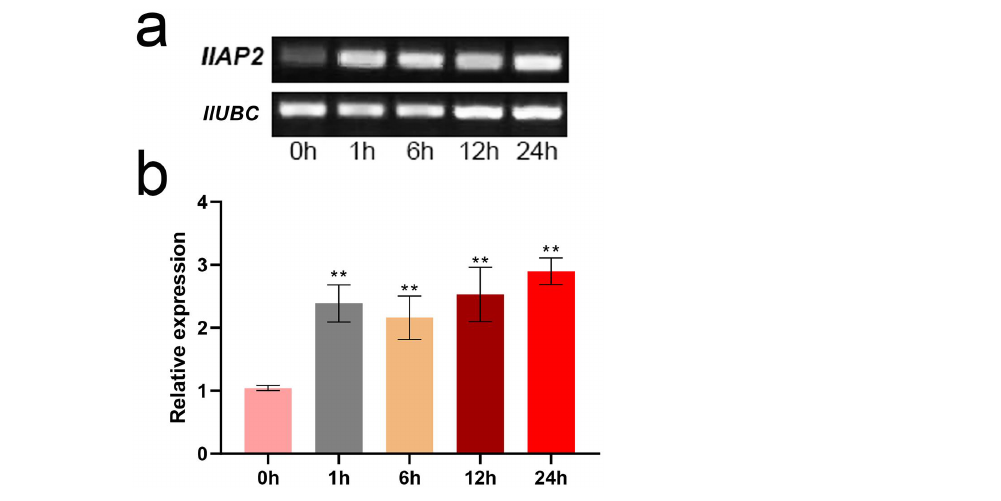
Figure 4. Analysis of IlAP2 expression pattern in I. lactea roots at different times of Cd stress: ( a ) semi-quantitative PCR and ( b ) RT-qPCR. ‘**’ shows the significance level of p < 0.01. 2.4. Functional Verification of I1AP2 in A. thaliana To investigate whether IlAP2 can improve Cd tolerance, we constructed I1AP2 - overexpressing A. thaliana and obtained eight homozygous T3-generation transgenic lines. Three independent transgenic lines were selected for functional verification: OE2, OE4 and OE5. After 10 days of growth (3-day-old seedlings were exposed to cadmium for 7 days), there was no significant difference in root length and growth between the WT and transgenic plants grown on normal half-MS medium. Under a 7-day Cd treat- ment, although the root length and growth of the WT and transgenic plants decreased continuously, the degree of decline for the transgenic plants was slower than that of the WT plants (Figure 5), suggesting that IlAP2 improved Cd tolerance in A. thaliana .